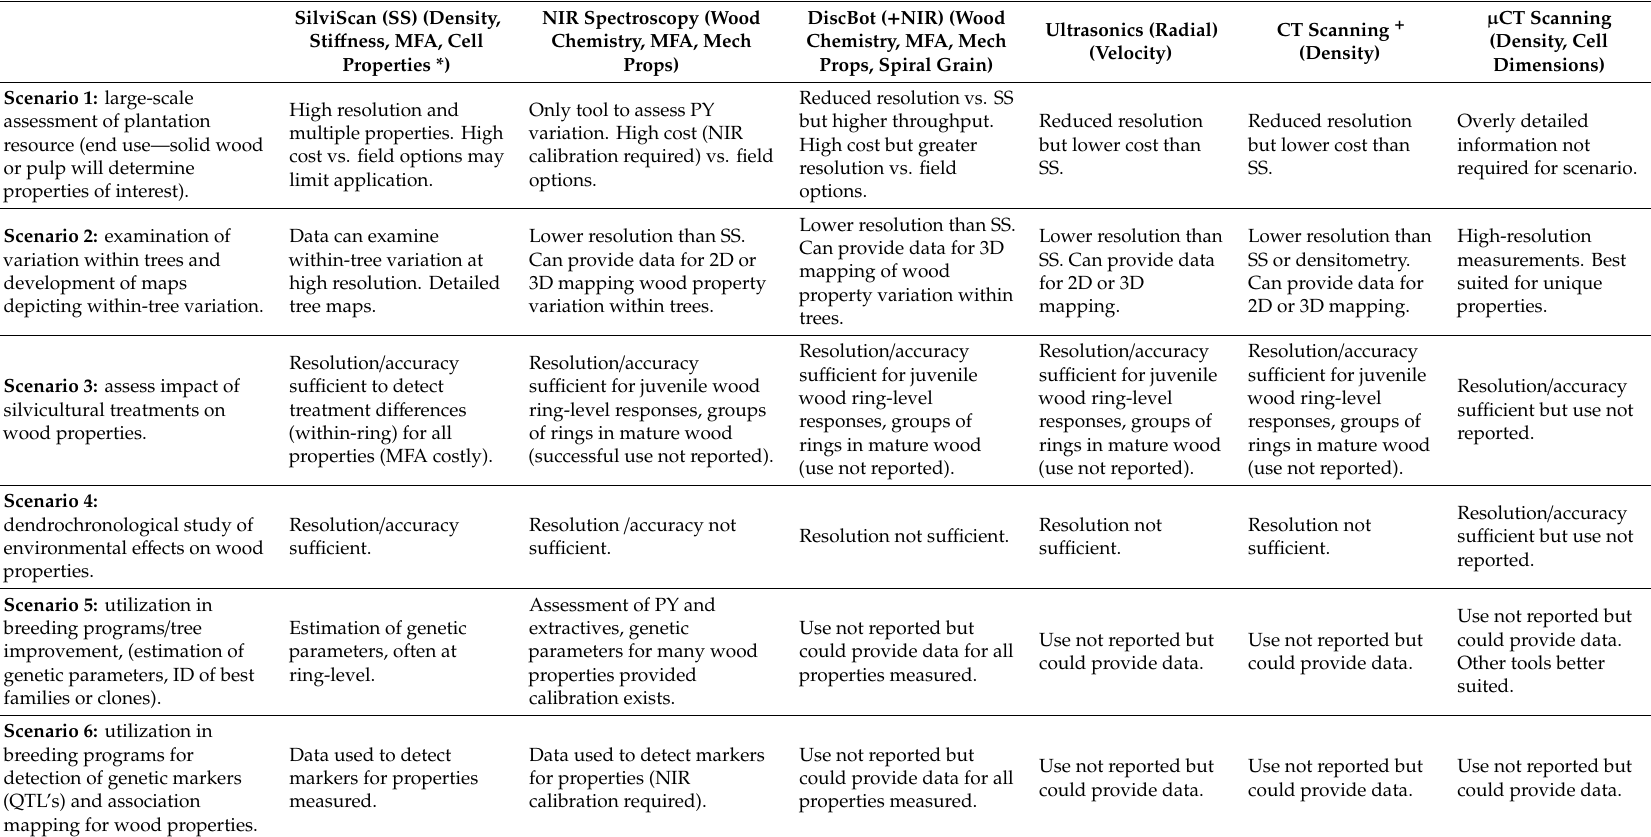
Table 3. Applicability of di ff erent lab-based NDE tools to operational and / or research